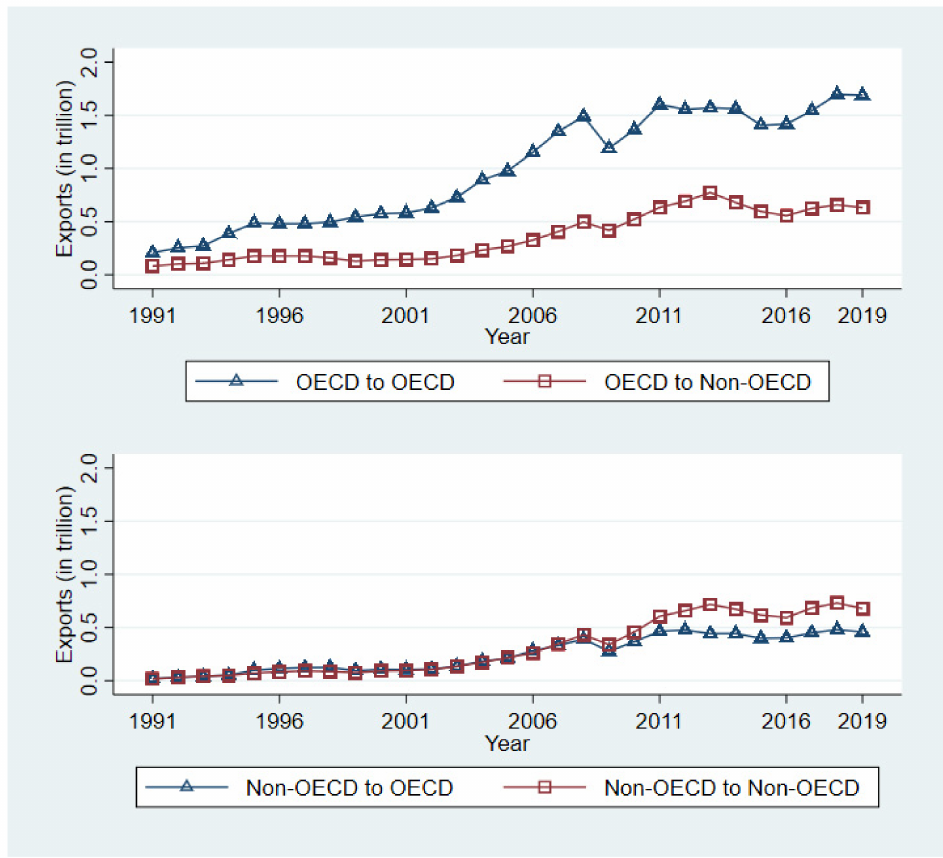
Figure 3. Trends of Bilateral Climate Exports. Note: Authors’ calculation by using the UN Comtrade data. Source: UN Comtrade. International Trade Statistics-Import/Export Data (accessed on 8 May 2021)